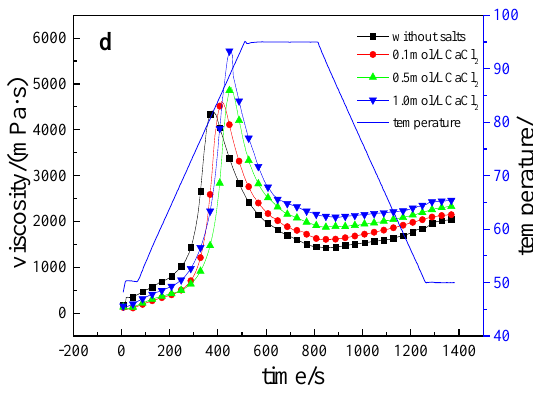
Figure 1. Pasting curves of LRS/KGM mixtures in acid or salt solutions. ( a ) acid (citric acid buffer); ( b ) NaCl; ( c ) KCl; ( d ) CaCl 2 . Table 1. Pasting parameters of the LRS/KGM mixed system in acid or salt solutions.